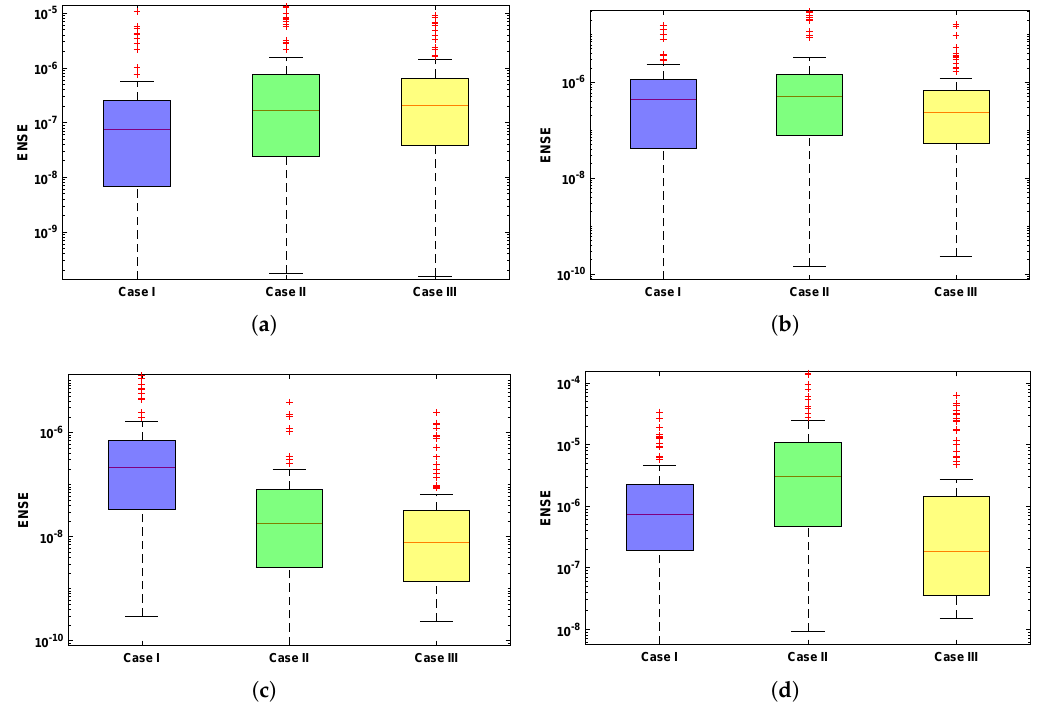
Figure 10. Boxplots showing distribution of ENSE values for four scenarios of the drainage problem. ( a ) SCENARIO I. ( b ) SCENARIO II. ( c ) SCENARIO III. ( d ) SCENARIO